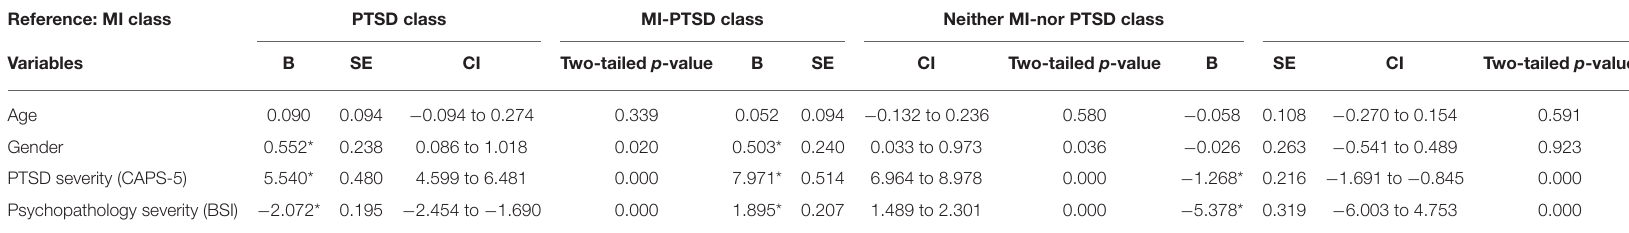
TABLE 5 | Results of the multinomial regression analysis of the four classes and the variables age, gender, PTSD severity, and psychopathology